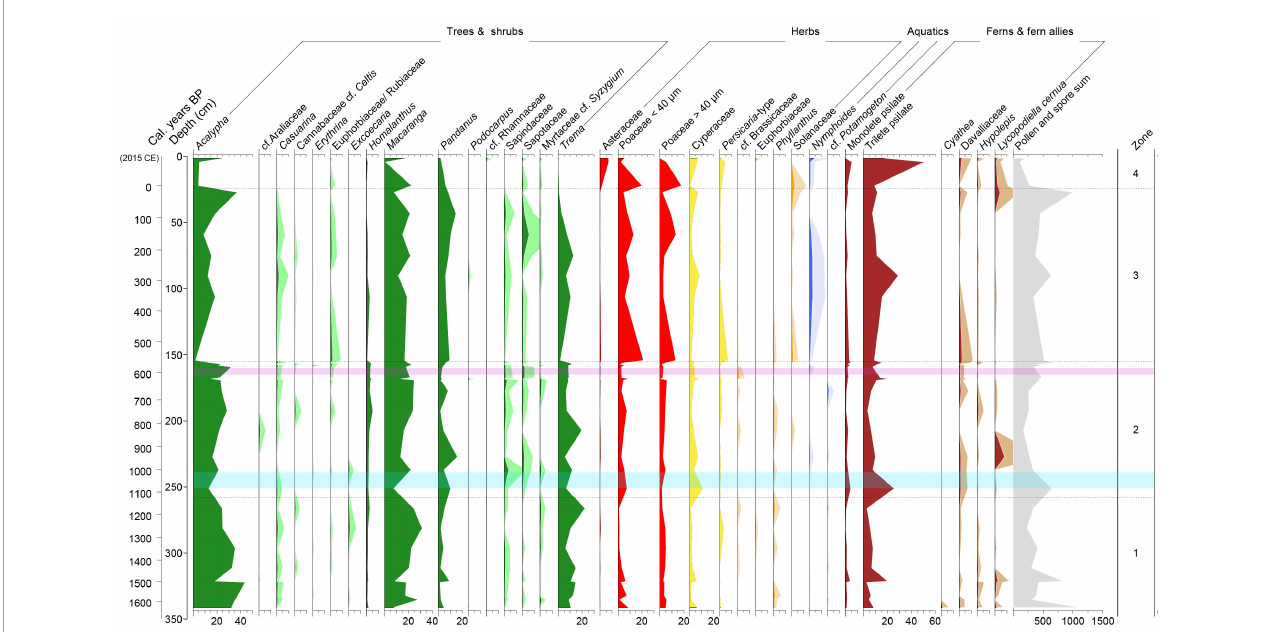
FIGURE3 Pollen percentage diagram for Lake Emaotul showing pollen and spores that have been taxonomically identified and have > 1% abundance in any one sample. Taxa are grouped into trees and shrubs (green), dryland herbs (red), wetland herbs (yellow), other herbs (orange), aquatic plants (blue), and ferns and fern allies (brown). Taxa that occur in low abundances have been shown with × 5 exaggeration (paler shaded areas). The purple-shaded area represents the area where Kuwae volcanic tephra was identified, and the pale blue shaded area is the period of climate shift from wetter to drier